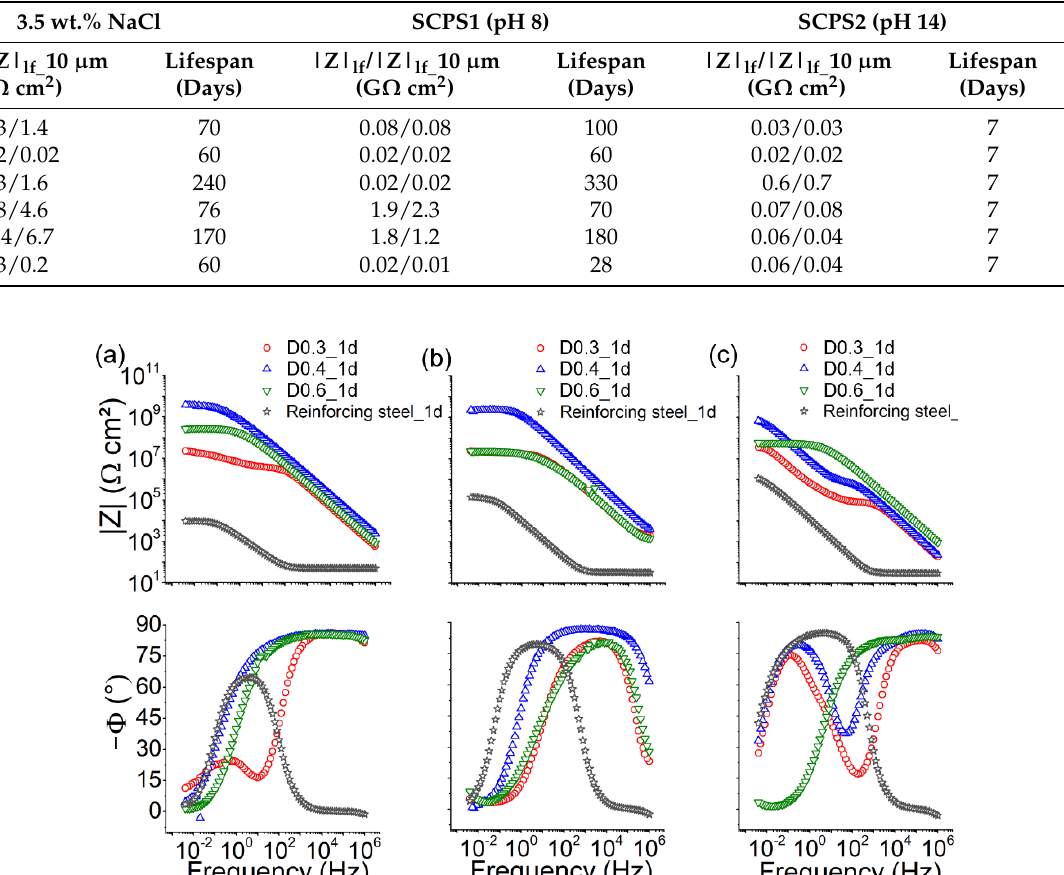
Table 5. Impedance modulus (|Z| lf ) after 1 day, |Z| lf normalized to the thickness of 10 µ m, and lifespan of epoxy–silica coatings on reinforcing steel recorded in duplicate during exposure to neutral saline and simulated concrete pore solutions.